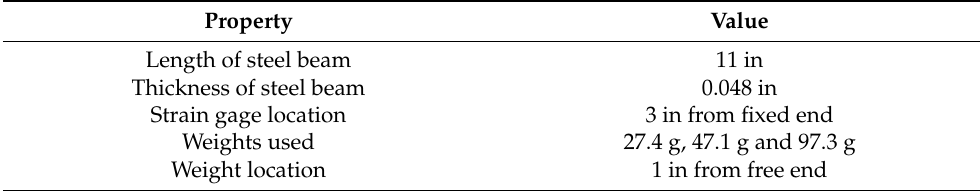
Table 1. Properties for static strain verification.